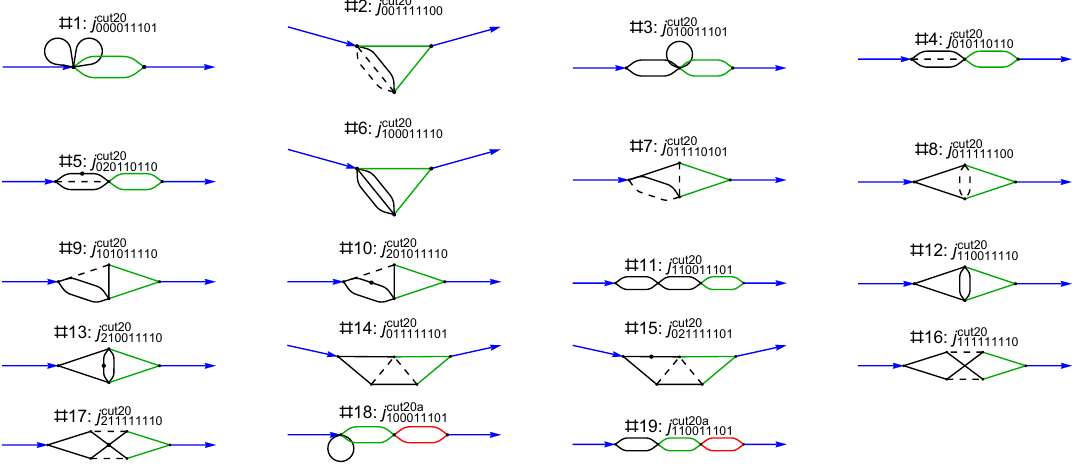
Here the green lines correspond to the cut propagators, while the red lines correspond to complex conjugated part of the diagram. Note that the integral j cut20a conjugate of j cut20 and we introduce it because it enters the differential equation for 010011101 j cut20a 110011101